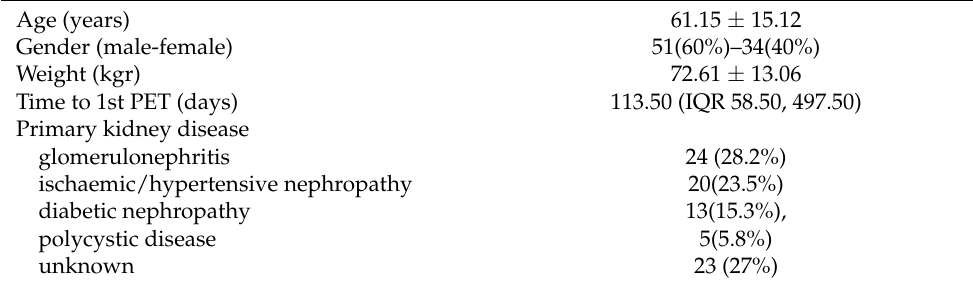
Table 1. Baseline clinical